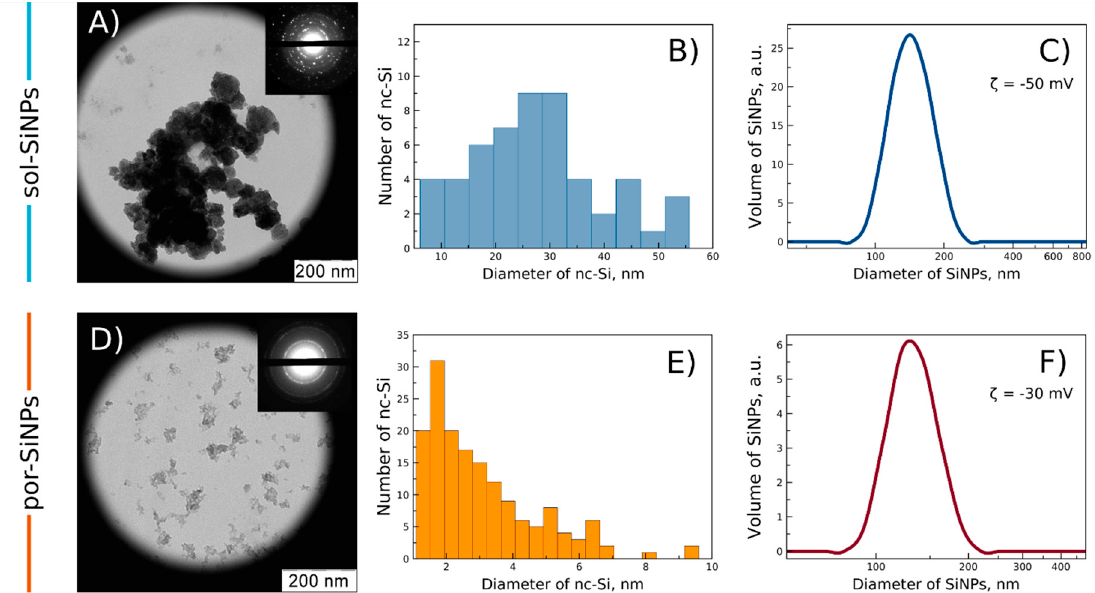
Figure 2. Characterization of SiNPs. TEM images of ( A ) sol-SiNPs and ( D ) por-SiNPs. The insets show corresponding diffraction patterns. Nanocrystal size (nc-Si) distribution of ( B ) sol-SiNPs and ( E ) por-SiNPs, obtained from dark-field TEM images. Dynamic light scattering data on SiNPs: hydrodynamic diameter distributions for sol-SiNPs ( C ) and por-SiNPs ( F ).